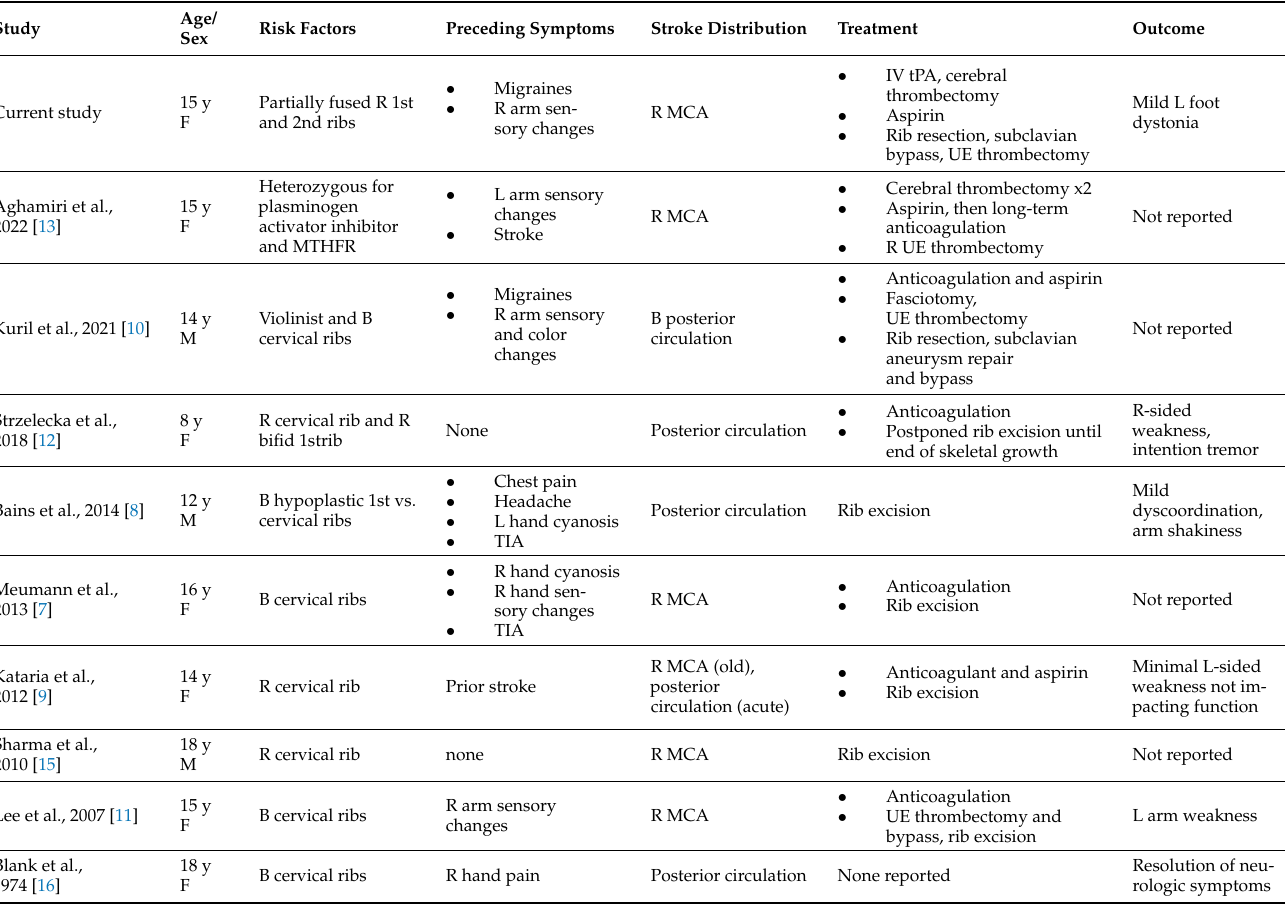
Table 1. Reported cases of pediatric stroke due to thoracic outlet